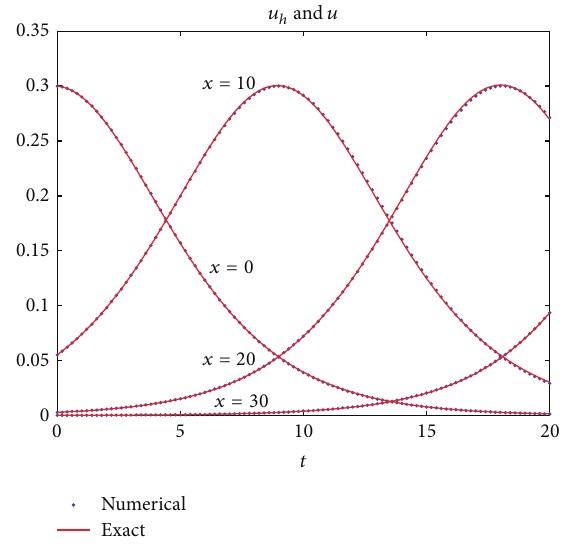
Figure 7: Comparison between 𝑢 and 𝑢 ℎ at spaces 𝑥 = 0 , 10 , 20 , and 30 with ℎ = 0.125 and Δ𝑡 = 0.2